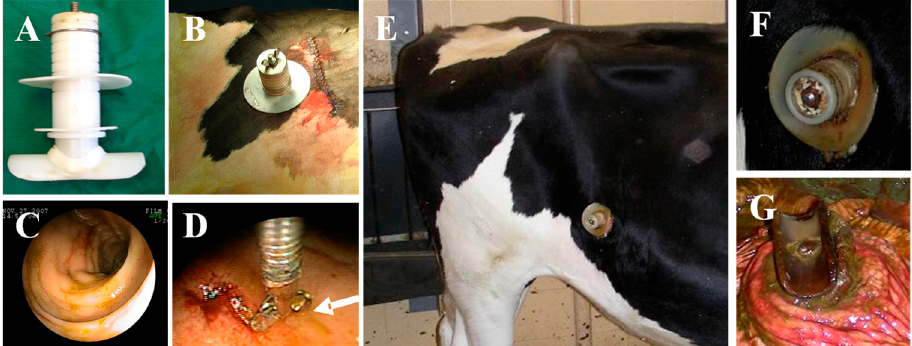
Figure 1. ( A ) Pictures showing the modified cannula used to cannulate calves before surgery. ( B ) Appearance of cannula after placement in the ileum. ( C ) Appearance of ileum before infection with Map . ( D ) Collection of a pinch biopsy. ( E , F ) Pictures showing the status of the cannula 8 months after surgery. Inflammation at the site of the implantation was kept at a minimum by keeping the site clean. ( G ) Inspection of internal portion of the cannula at necropsy showed minimal inflammation around the cannula [26].